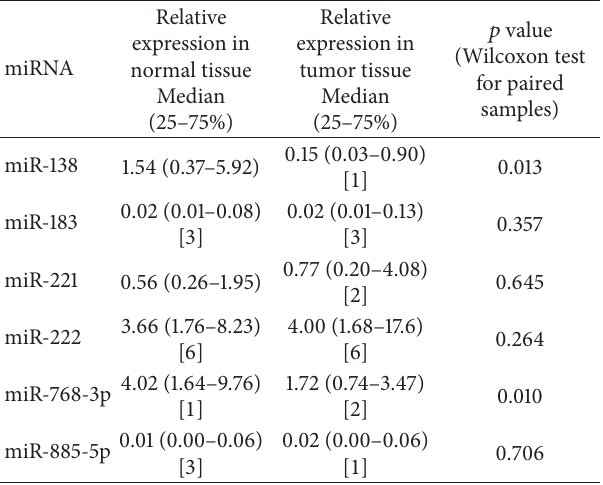
Table 2: Relative expression of miRNAs in normal and tumor samples of all patients.